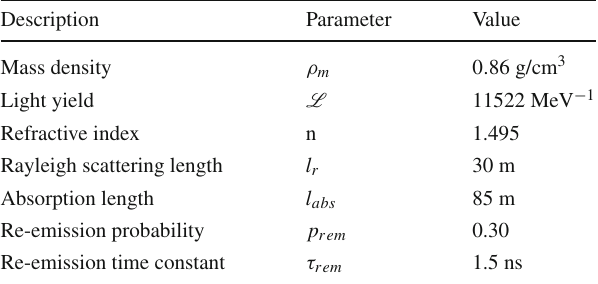
Table 2 General parameters of the LAB (PPO, Bis-MSB) scintillator used in the simulation. The initial emission spectrum used corresponds to Bis-MSB. For the wavelength-dependent properties, the value at 430 nm is quoted